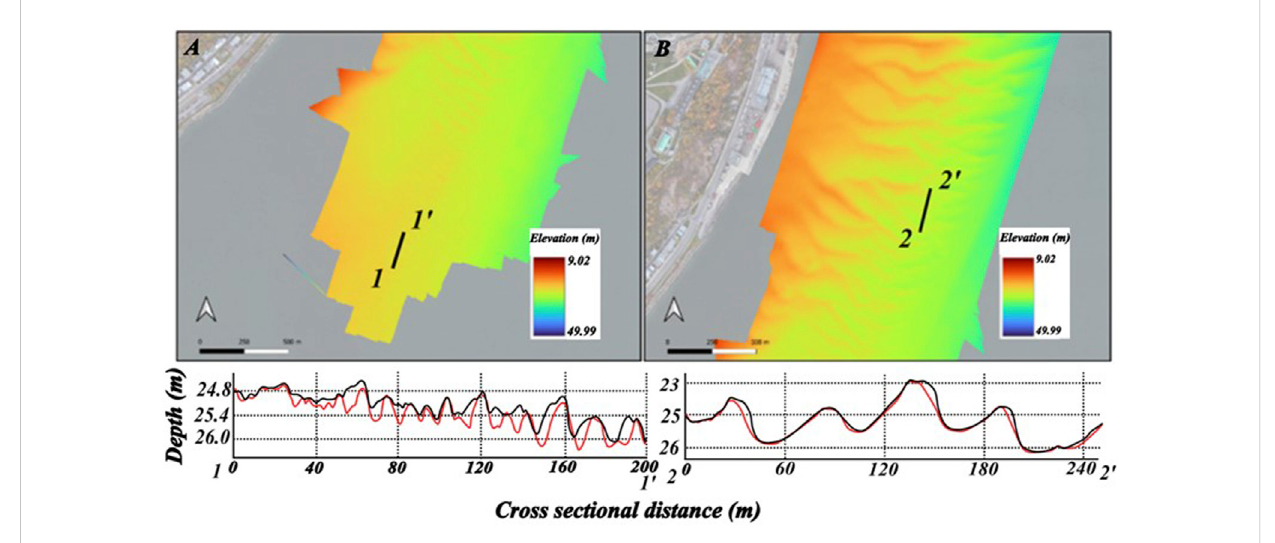
FIGURE 12 Cross-sectionpro fi lethroughthedune fi elds.Ontheleft,[cf. (A) ],apro fi leextractedthroughthesmalldunesinthesouthofthestudyarea(1-1 ′ ).On theright, [cf. (B) ],apro fi le extracted through thelarger dunes in thecenterof thestudy area (2-2 ′ ).In black, thepro fi le ofthe multisource DBM and in red the pro fi le considering only the data acquired on July